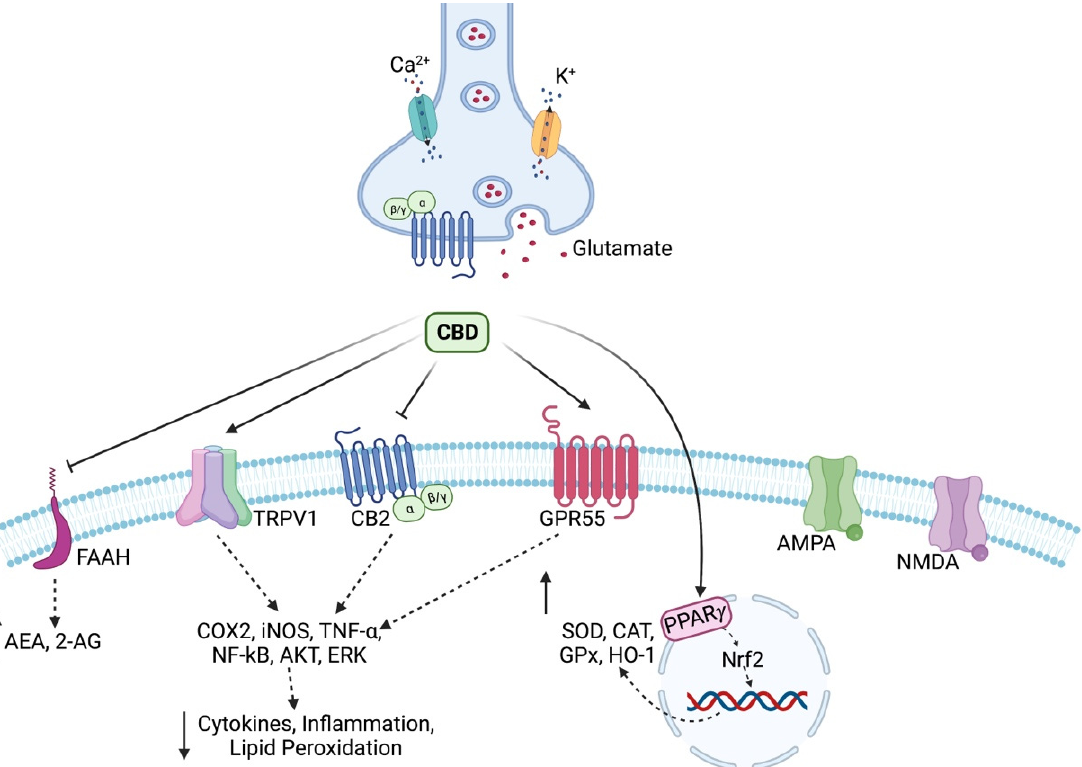
Figure 1. Cannabidiol has the property of inhibiting the fatty acid amide hydrolase (FAAH) enzyme with a consequent increase in the availability of anandamide (AEA) and 2-arachidonoylglycerol (2-AG), which are substances of the endocannabinoid system considered to be reverse mediators of depolarization-induced inhibition. Thus, it prevents the release of glutamate, which no longer acts on AMPA and NMDA receptors. At the same time, CBD, through TRPV1, GPR55, and CB2 receptors, prevents the generation of cytokines with a pro-inflammatory role, and in addition, through the PPAR γ receptor, it increases the expression of endogenous antioxidant systems via the Nrf2 pathway. Created with